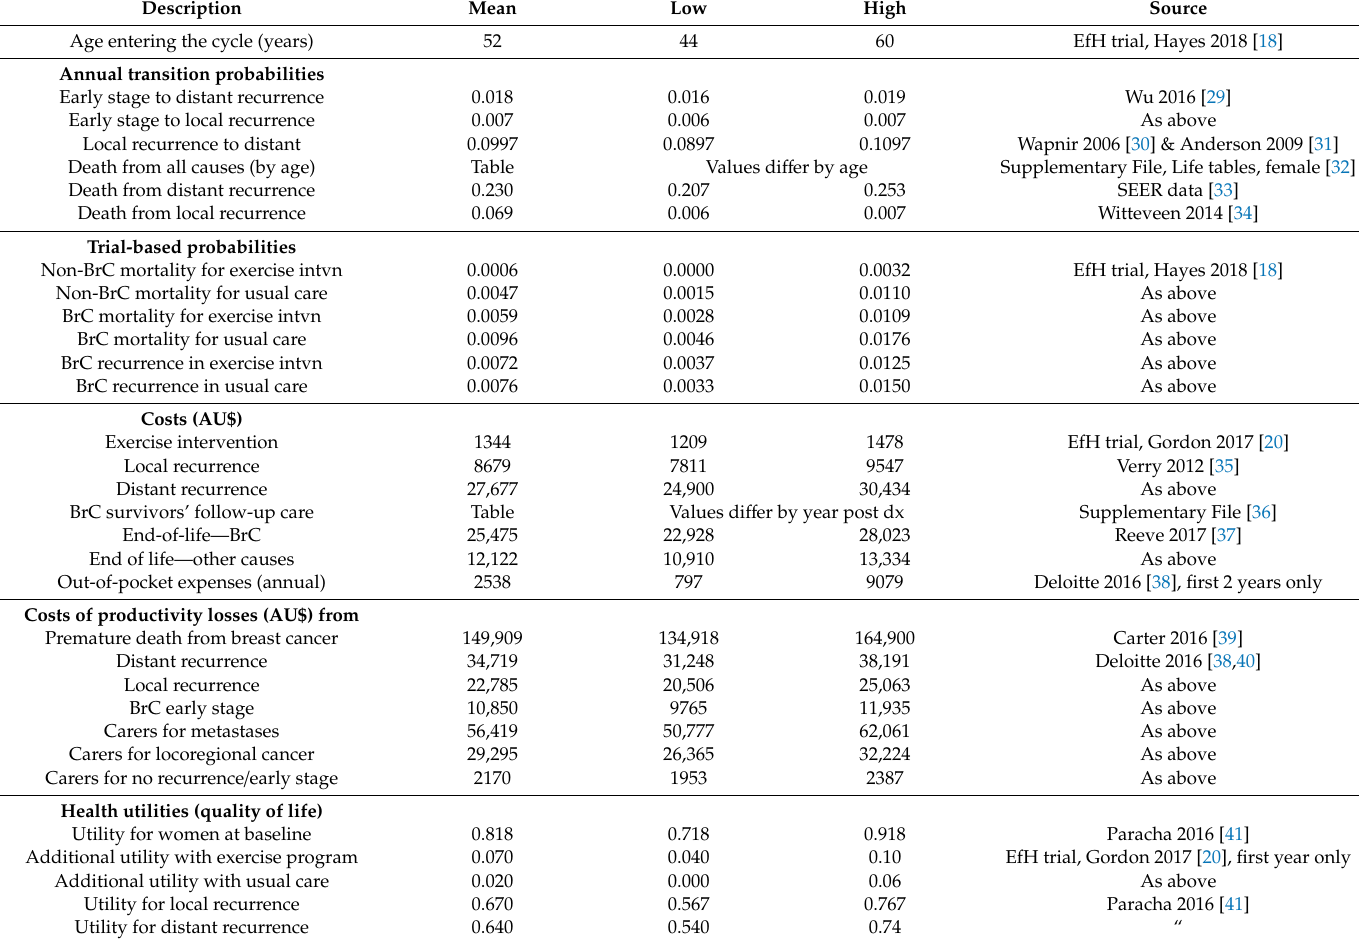
Table 1. Model inputs, mean, and sensitivity values and